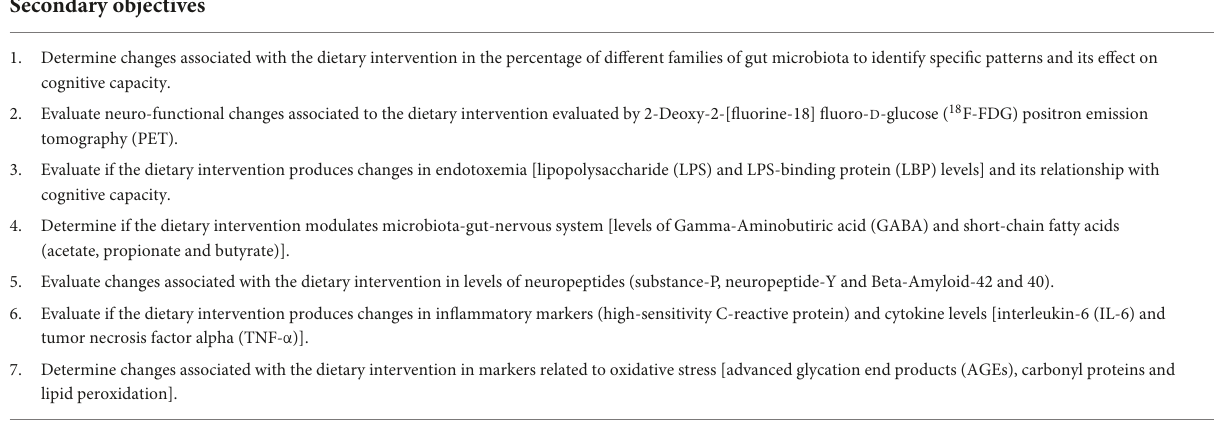
TABLE 3 Description of the main and secondary objectives of the